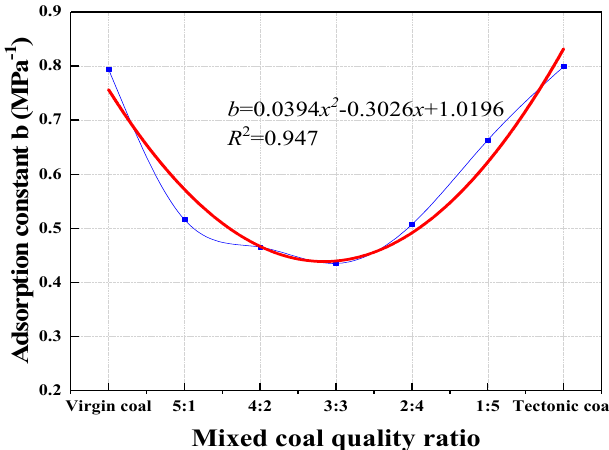
Figure 8. Curve of the relationship between the adsorption constant b and the mass ratio of hard to soft coal.